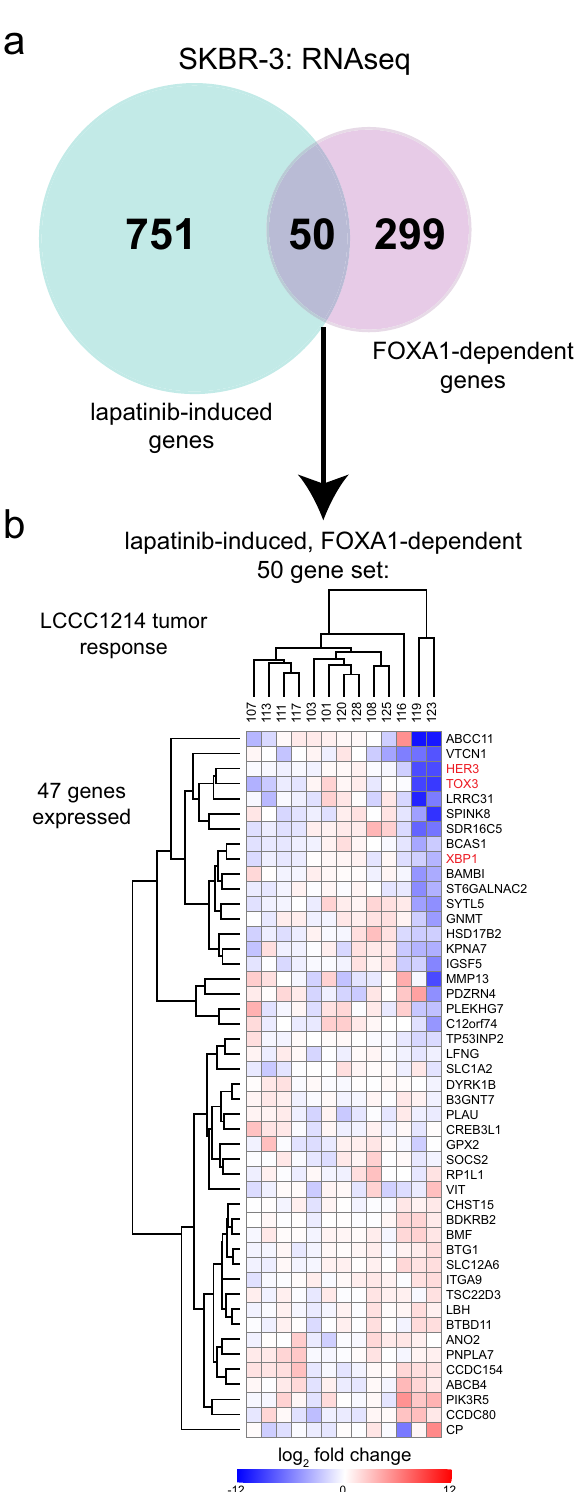
VTCN1 . The broad effects on enhancers, gene expression, and phenotype imply that multiple genes may be involved, possibly a TF network, but that FOXA1 reduction elicits a signi fi cant response to lapatinib. Taken together, these fi ndings suggest that an ER- independent role is played by FOXA1 in mediating adaptive responses to HER2 inhibition.